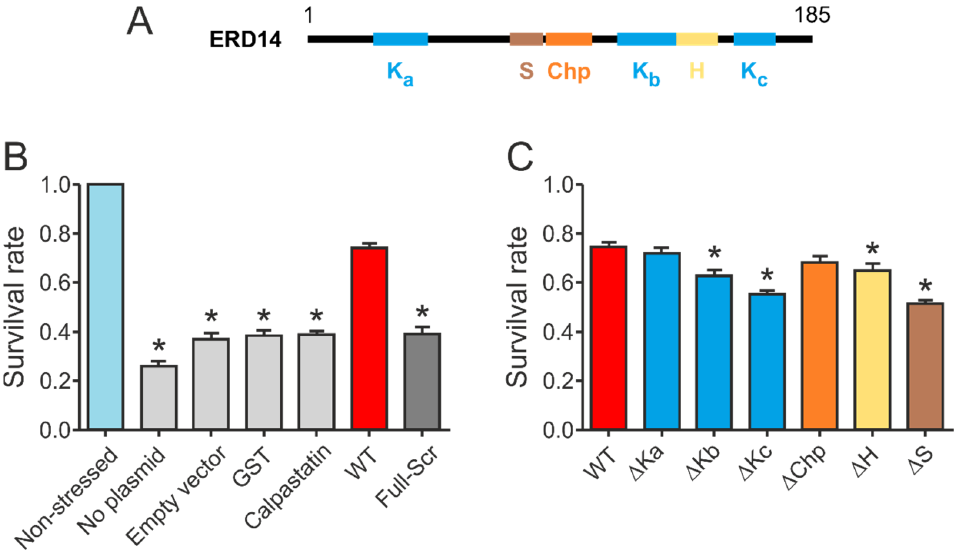
Figure 3. Conserved regions of ERD14 contribute to cell protection. ( A ) Schematic representation of the conserved regions within ERD14. ( B ) Survival rate (viability) is reduced by the applied heat stress to 26.2% (compared to non-stressed cells) for non-transformed cells, 36.8% for cells containing an empty vector, and about 39% in the case of overexpression of control proteins: GST (38.4%) and IDP calpastatin (38.7%). Overexpression of ERD14 increases the survival rate to 74.5%. Removing the conserved regions by randomizing the amino acid sequence (Full-Scr) abolished the protective effect (viability 38.9%). ( C ) Protective effect of a series of mutants in which conserved regions of the protein have been individually deleted. Data represent mean ± SEM and the results of at least 18 parallels for each construct. Significant differences ( p < 0.05) compared to WT ERD14 are labeled with asterisks